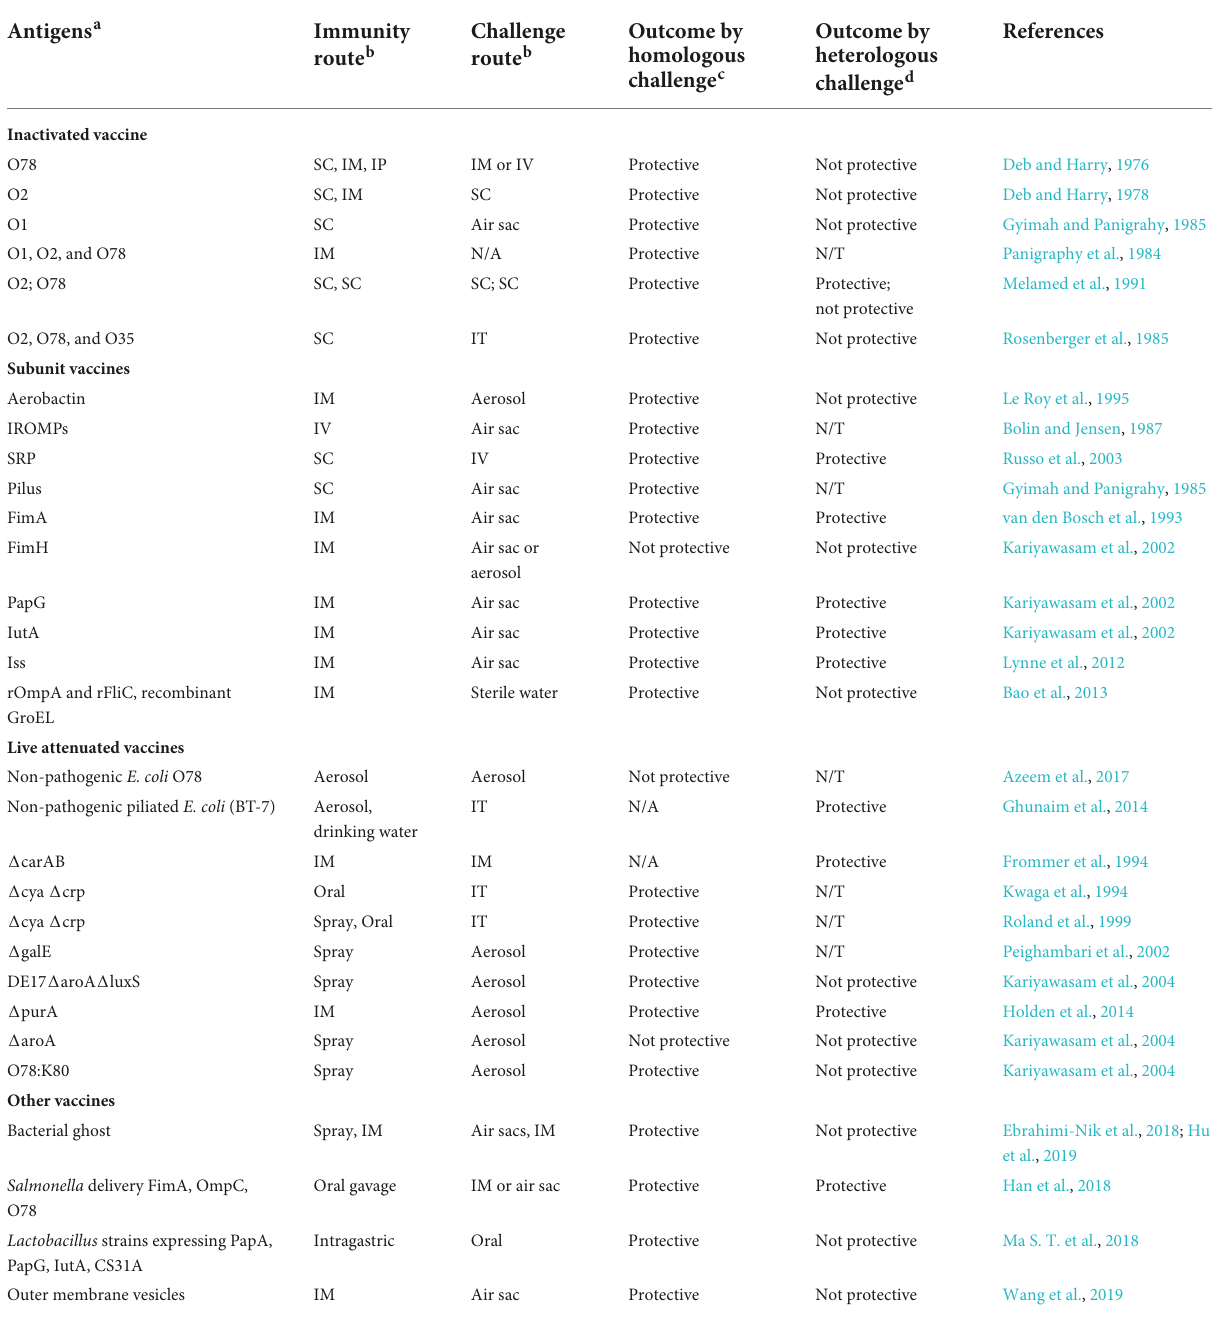
TABLE 2 Summary of vaccines development against APEC infection. Antigens